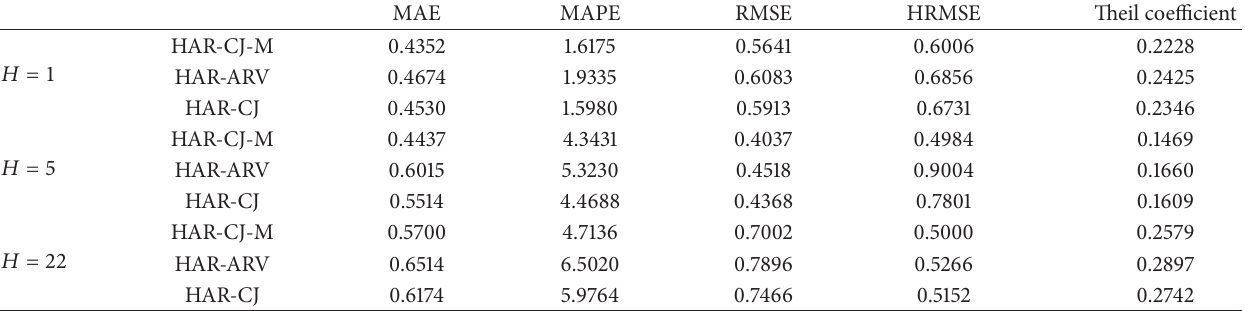
Table 6: In-sample forecast